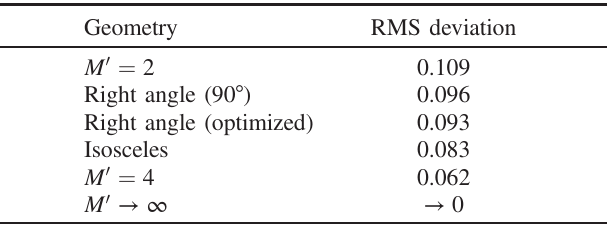
TABLE I. RMS deviation between ideal Halbach magnetiza- tion and discrete magnet vector, by geometry. Geometry RMS